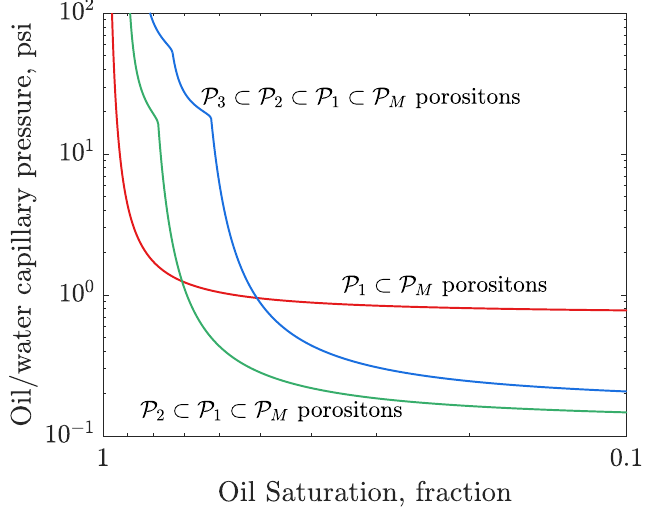
Figure 1. The 480 carbonate core samples in the database in Appendix A3 of [24] can be de- scribed by one, two or three nested macro- and micro-pore systems, each characterized by a unique Thomeer [25,26] hyperbola. The capillary entry pressures into the macroporosity that sur- rounds the microporous regions are significantly lower than the capillary pressure plateaus that span 30 to 60 plus percent of the total